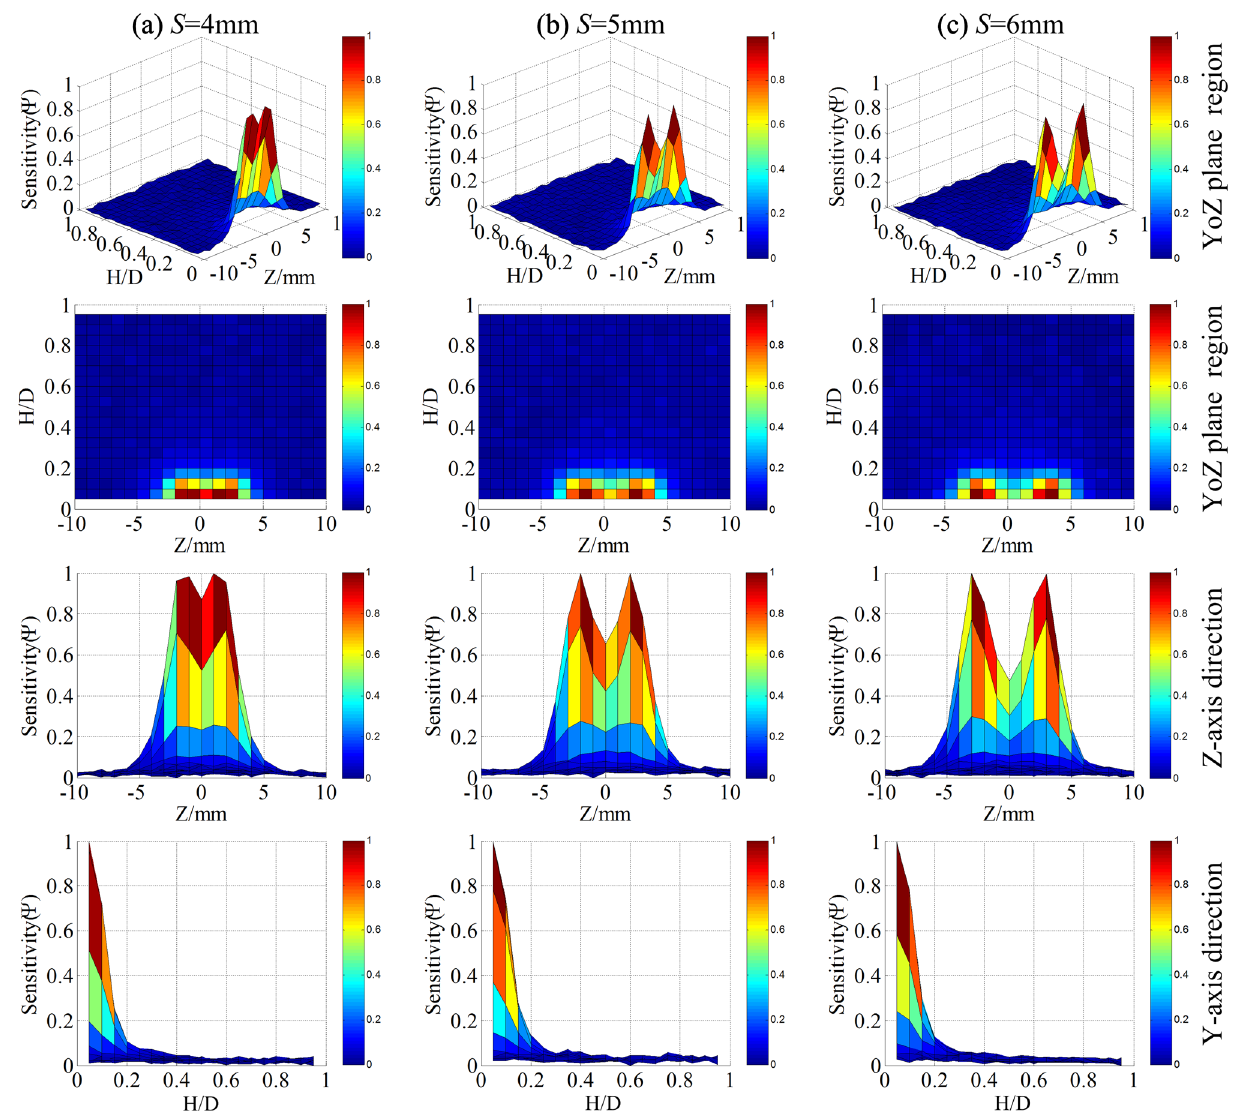
Fig. 5 Distribution maps of spatial sensitivity of MCP 1 under three different S values: D = 20 mm, h = 2 mm and d = 1.5